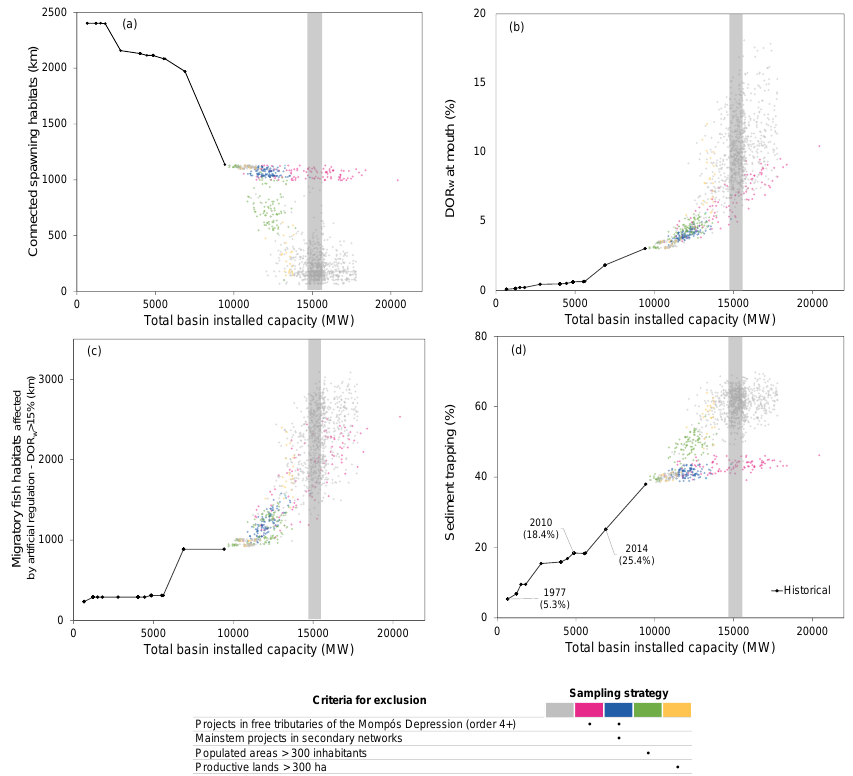
Figure 8. Indicators of basin-level cumulative alteration of historical hydropower development and randomly generated expansion sce- narios (dots) using different sampling strategies (differentiated by color). Shaded area shows the range of expected capacity by 2050 (15250 ± 500MW). (a) Longitudinally connected migratory fish spawning habitat (river length) at 400–1000ma.s.l. (b) Cumulative stream- flow regulation measured as weighted degree of regulation (DOR w ). (c) Migratory fish habitat (river length) affected by artificial regulation (DOR > 15%). (d) Total sediment trapping in reservoirs upstream of the Mompós